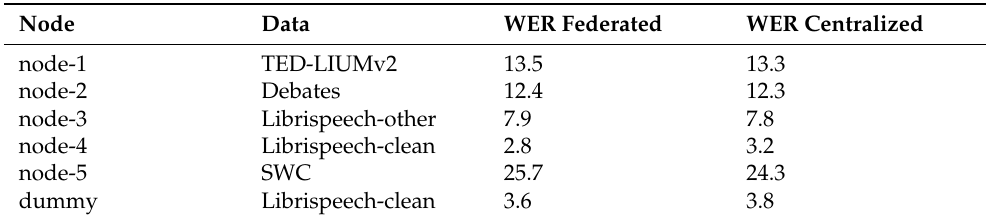
Table 6. Results of the FL pilot comparing WERs from Wav2Vec2.0 models trained in a federated or centralized